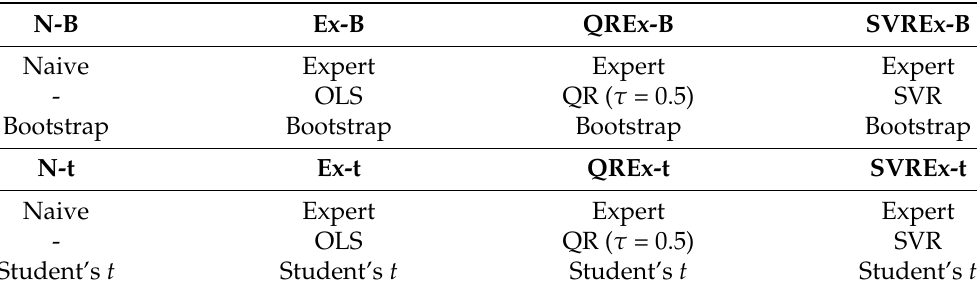
Table 1. Specification